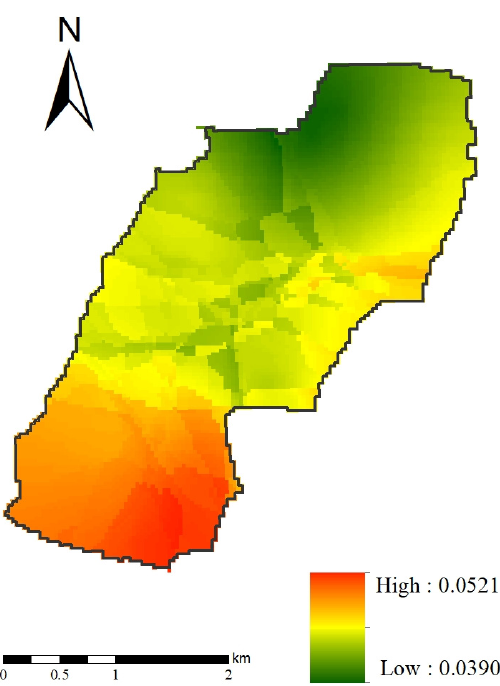
Figure 5. Spatial distribution of soil erodibility K values in the watershed (t·hm 2 ·h/(hm 2 ·MJ·mm)).